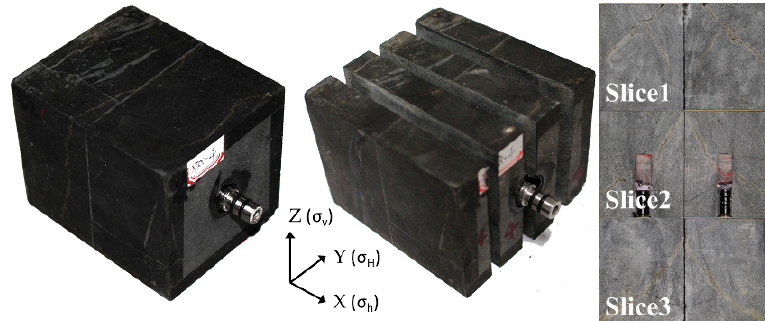
Figure 5. Fracture reconstruction after cutting the fractured specimen.